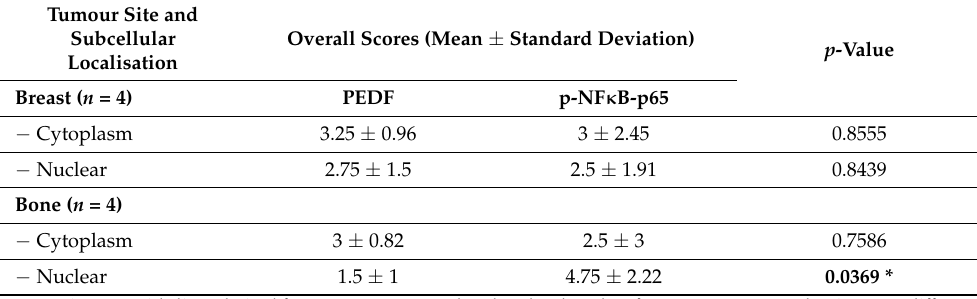
Table 2. PEDF and p-NF κ B scores (mean ± standard deviation) of ER+/HER2- breast cancer and bone metastases